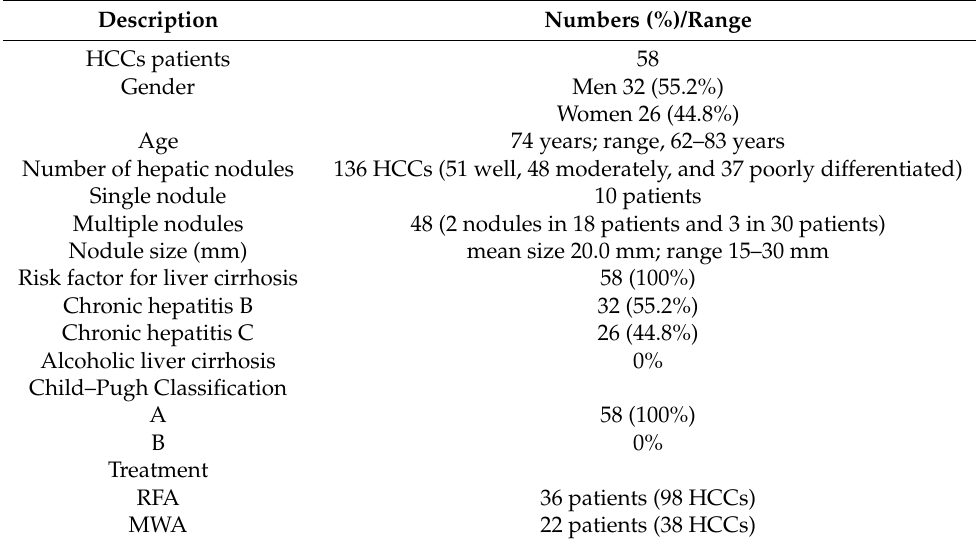
Table 1. Patients’